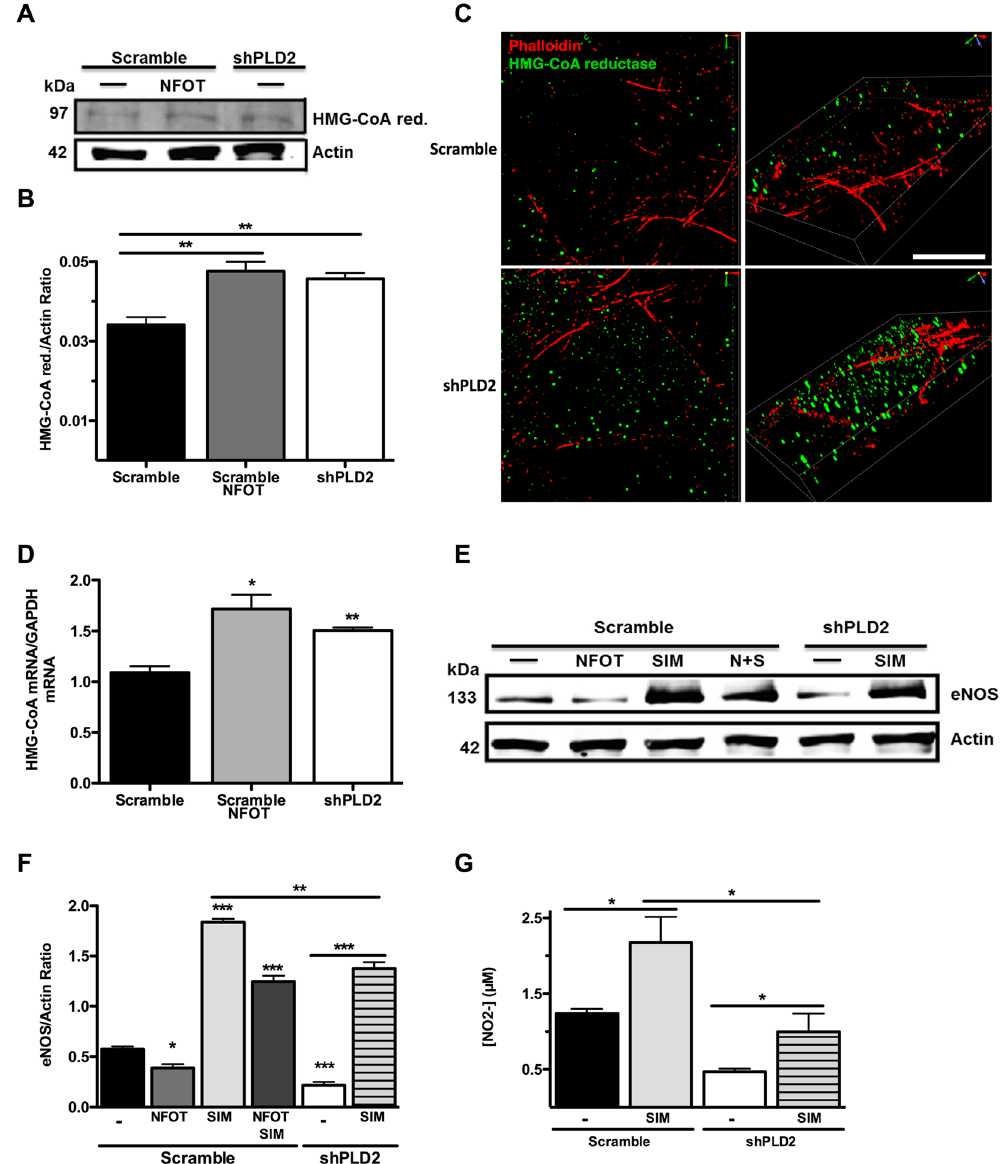
Figure 5. Upregulation of HMG-CoA reductase in shPLD2 cells decreases eNOS expression. ( A ) Representative western blot of HMG-CoA reductase in Scramble and shPLD2 cells. The regions of the Western blots containing the HMG-CoA reductase and actin immunoreactive bands were scanned and the relative abundance of the individual samples quantified using an Odyssey CLx imaging system ( B ) Quantification of western blots with HMG-CoA reductase normalized to actin (n = 4 experiments). ( C ) N-SIM microscopy of HMG-CoA reductase; Bar, 7.5 μ M. ( D ) RT-PCR of HMG-CoA reductase in Scramble and shPLD2 cells (n = 3). ( E ) Western blot of eNOS after treatment with NFOT and Simvastatin. Representative image of 3 experiments. The regions of the Western blots (Suppl. Figure 2) containing the eNOS and actin immunoreactive bands were scanned and the relative abundance of the individual samples quantified using an Odyssey CLx imaging system. ( F ) Quantification of western blots with eNOS levels normalized to actin (n = 3). Comparisons without bars made to untreated Scramble values. ( G ) eNOS activity after treatment with Simvastatin (n = 7). Mean ± SEM; * p < 0.05; ** p < 0.01; *** p ≤ 0.001; One-way ANOVA with Bonferroni’s Multiple Comparison